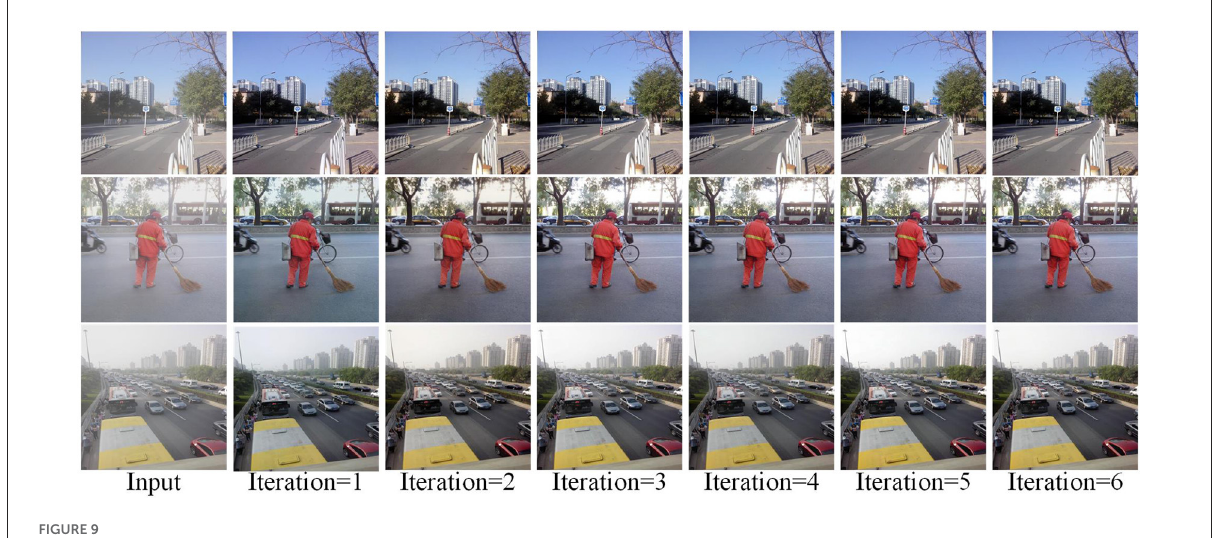
FIGURE9 Single image defogging image obtained in different iterations.